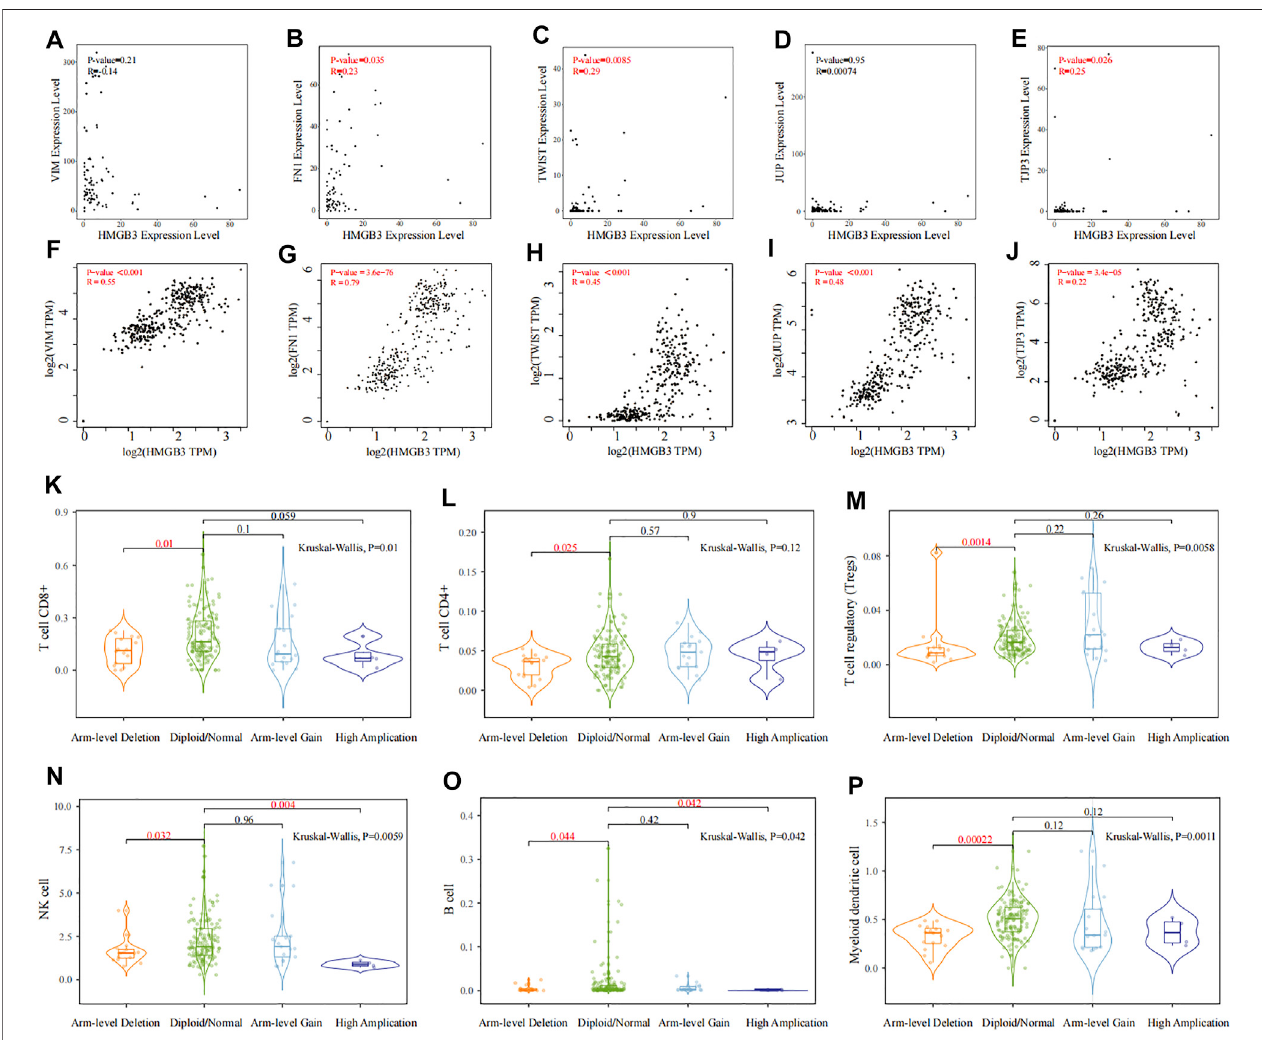
FIGURE 9 | Correlation analysis of HMGB3 with EMT, CTC clusters, and immune cells. (A – E) Correlation analysis between HMGB3 expression and VIM, FN1, TWIST, JUP, and TJP3 in GSE14456, respectively. (F – J) Relationship between HMGB3 expression and VIM, TWIST, JUP, and TJP3 through the GEPIA 2 database, respectively. (K – P) RelationshipofHMGB3mutationwithtumor-associatedCD8 + Tcell,CD4 + Tcell,Tcellregulatory,NKcell,Bcell,andmyeloiddendriticcellin fi ltrating levels by TIMER2.0,